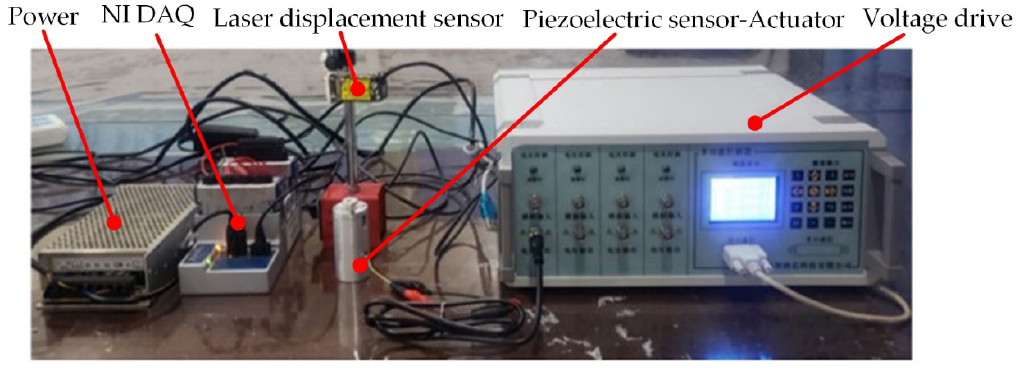
Figure 4. Experimental schematic diagram.